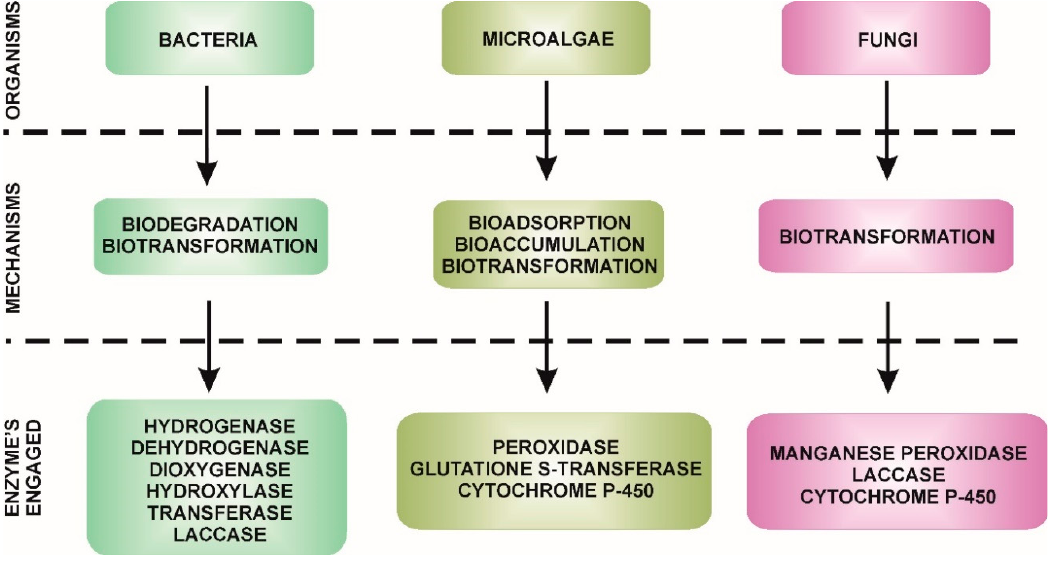
Figure 1. The main mechanisms for removing EDCs [3,9,26,30].